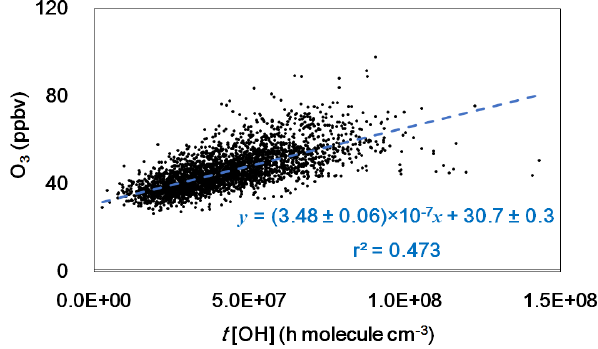
Figure 9. Scatter plot of ozone mixing ratio versus photochemical age ( t [OH]). The data points with the ozone mixing ratios less than 25ppbv were excluded from the linear